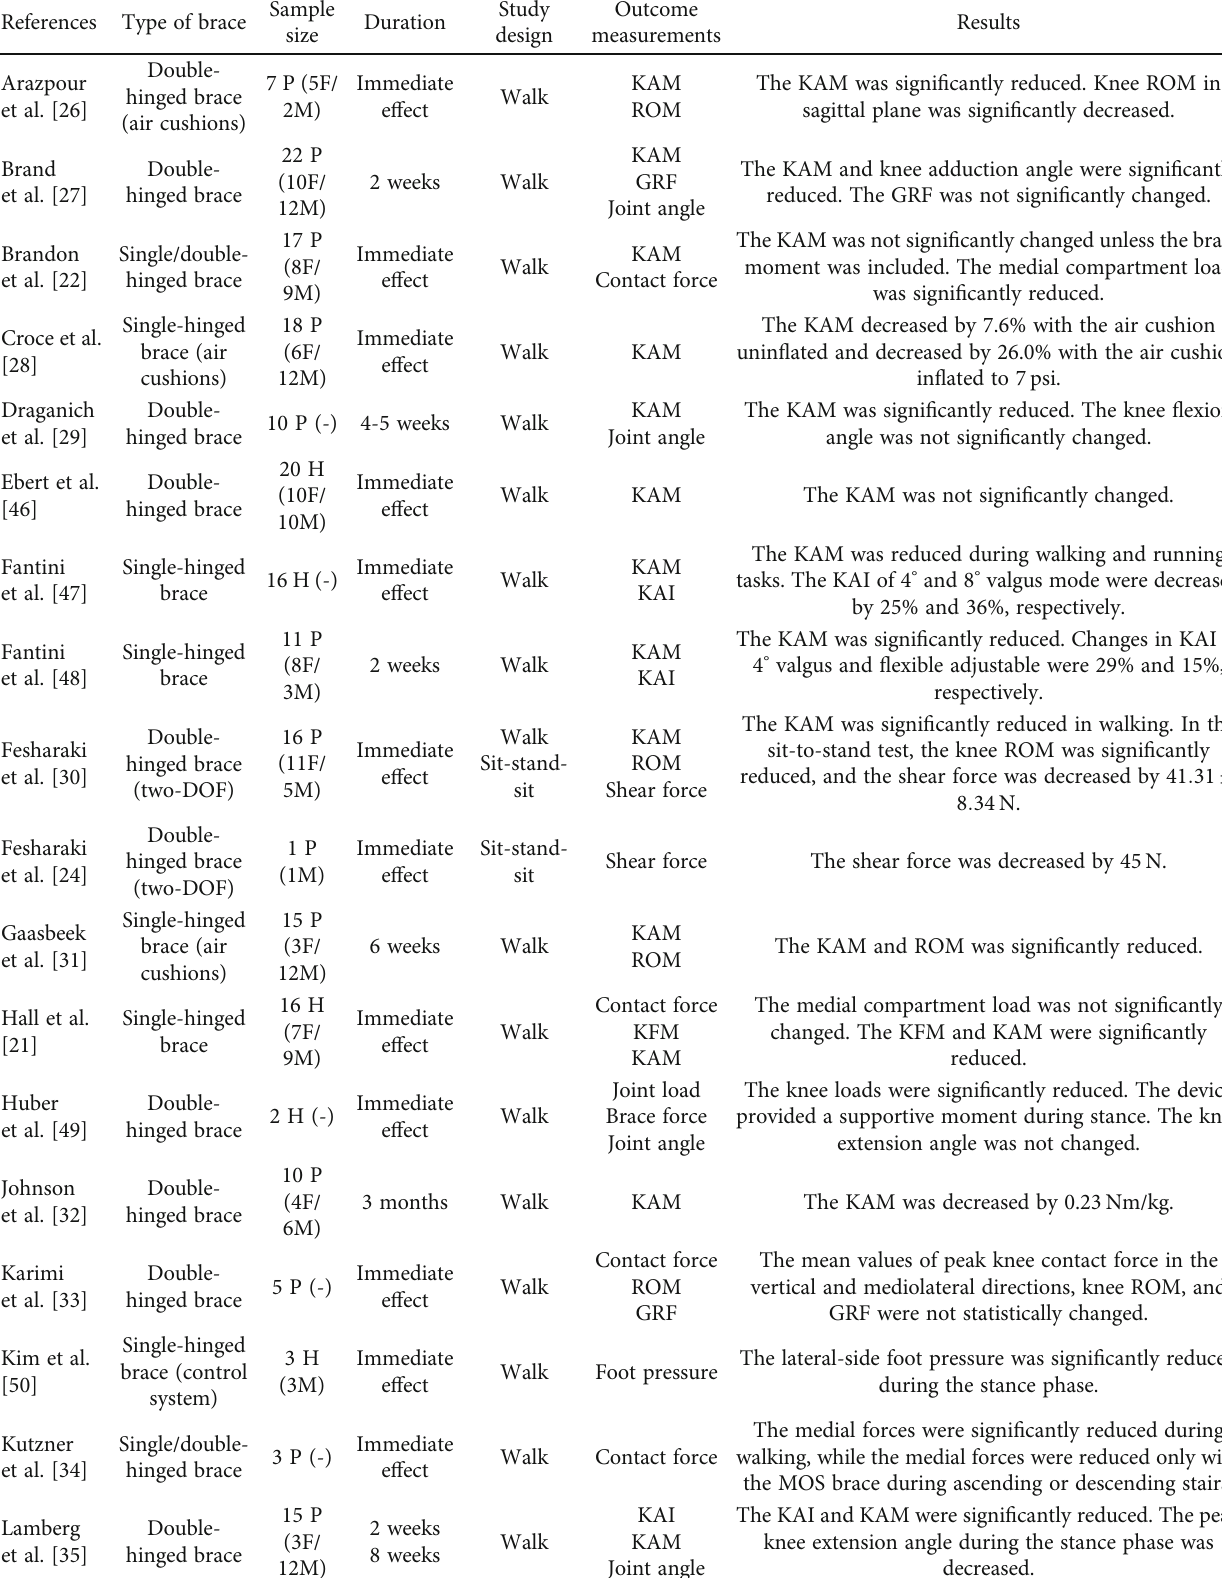
Table 3: Studies that evaluated the e ff ect of knee brace on kinetic and kinematic parameters in medial gonarthrosis. Sample Study References Type of brace Duration size design